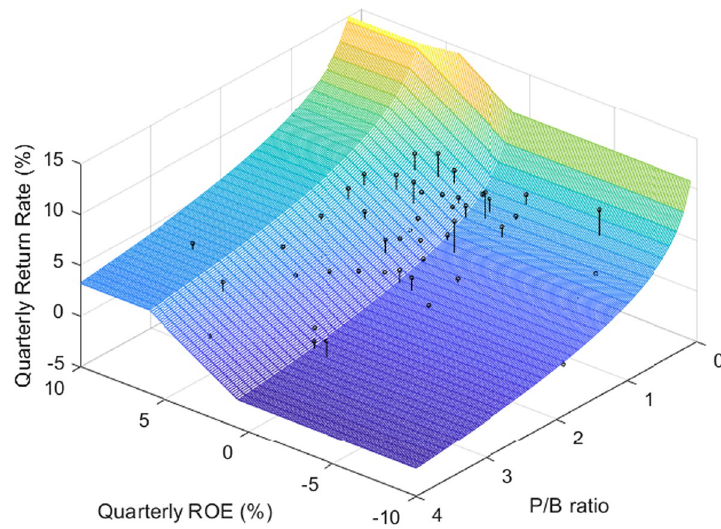
Fig. 40 3D scatter diagram of ROE (X), P/B (Y) in the t quarter, and return rate in the t actual values, another end: predicted values): Modified GVM